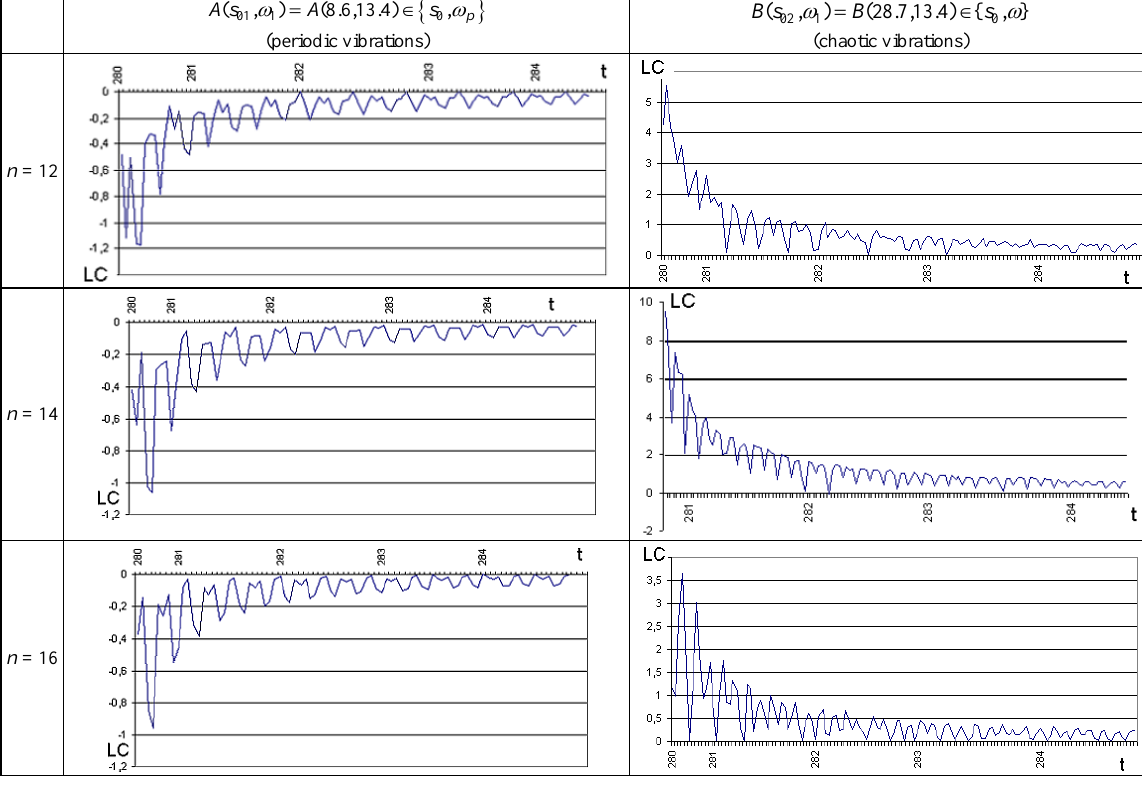
Fig. 3. The Lyapunov exponents time histories versus n in periodic and chaotic